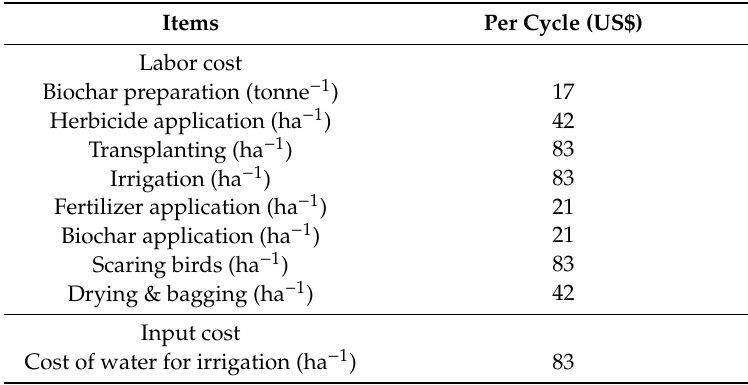
Table 1. Production costs for irrigated rice using rice-husk biochar and fertilizer (2012–2014) in Kpong,